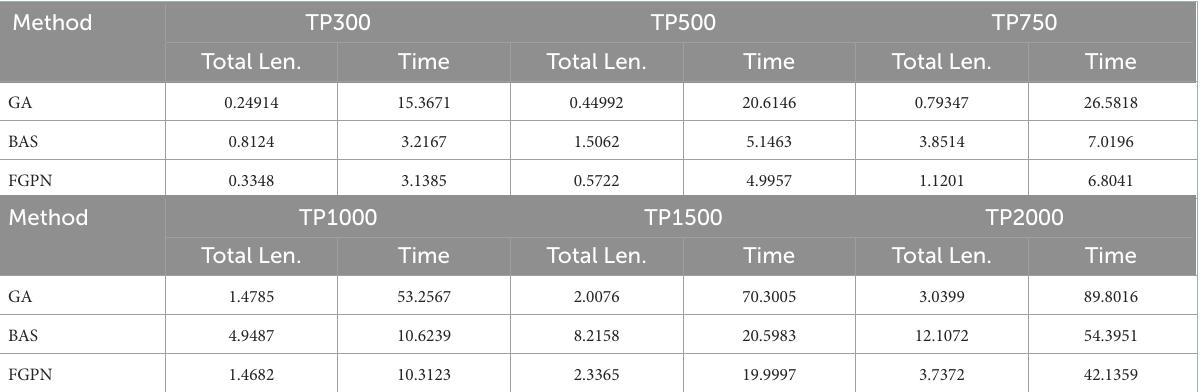
TABLE 4 The relationship between the solution time and the total moving distance and the scale of the task nodes when the number of target task nodes in the task cluster is about 60. The unit of total Len. in the table is 10 6 m , and the unit of Time is seconds.